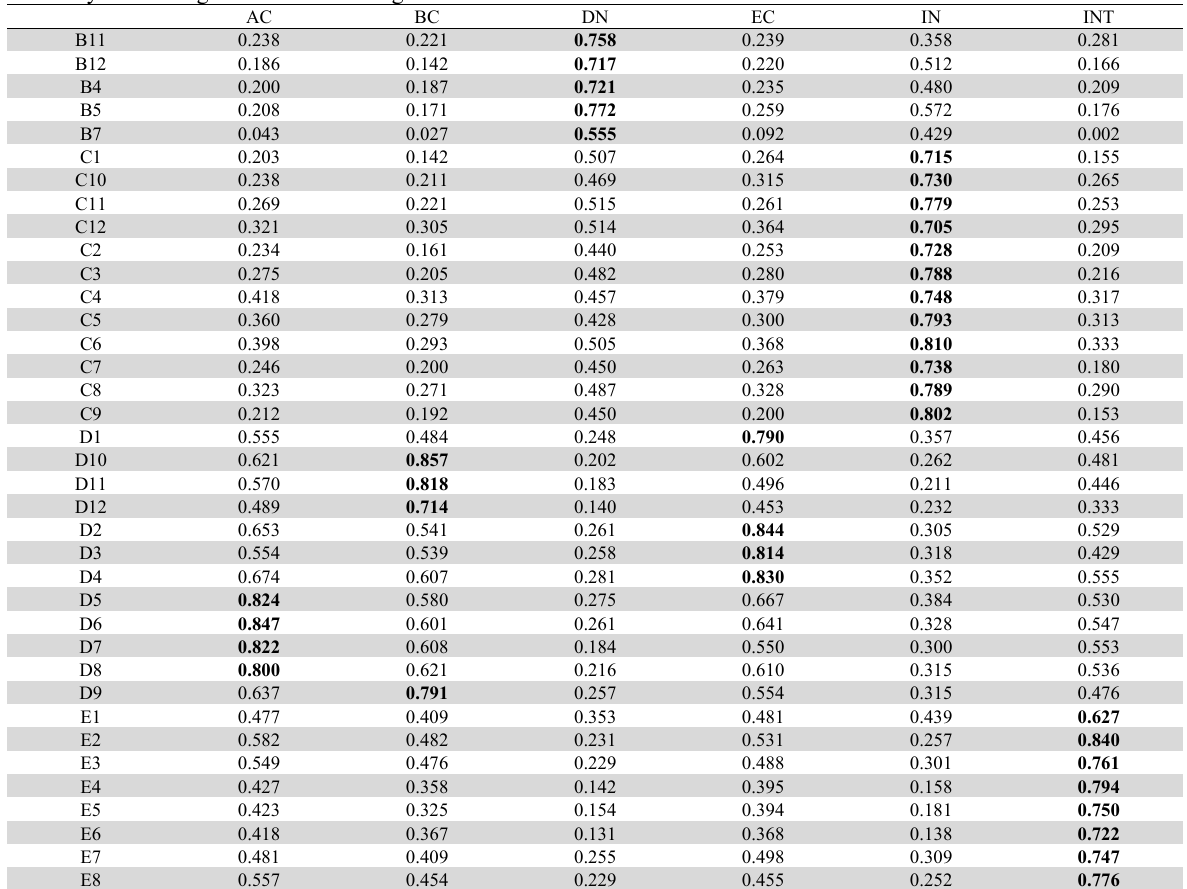
Summary of Loadings and Cross-Loadings